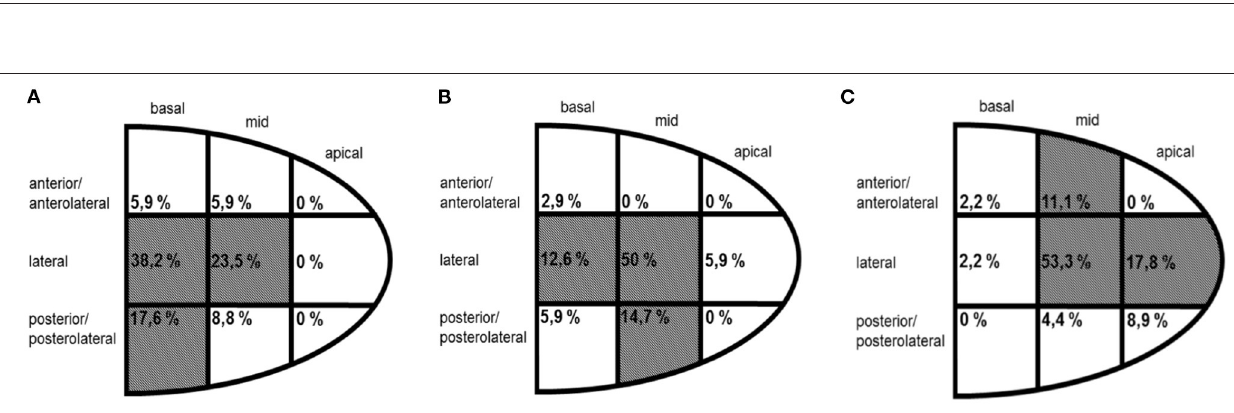
FIGURE 3 | Estimated vein size for bipolar active fixation lead at coronary sinus (A) , the helix of the electrode (B) and the tip of electrode (C) and estimated vein size for quadripolar passive fixation group at coronary sinus (D) , imaginary helix position (E) of the electrode (36mm from the tip) and the tip of electrode (F) presented in different categories of size in French (x-axis) analyzed in percentages (%) by a bar chart.